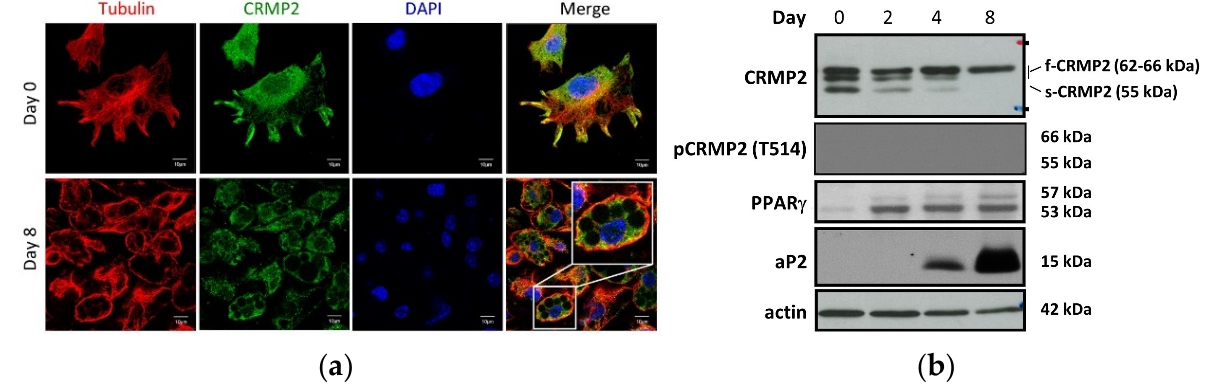
Figure 1. CRMP2 expression pattern in undifferentiated pre ‐ adipocytes and during the process of adipogenesis. 3T3 ‐ L1 pre ‐ adipocytes were induced to enter differentiation scheme by MDI cocktail on day 0. ( a ) Distribution of CRMP2 and α -tubulin before (day 0, upper panel) and after (day 8, lower panel) differentiation was visualized by confocal imaging (scale bar = 10 µ m). ( b ) Expression of CRMP2 and adipocyte markers was temporally examined by Western blotting at the indicated time ( n = 6).